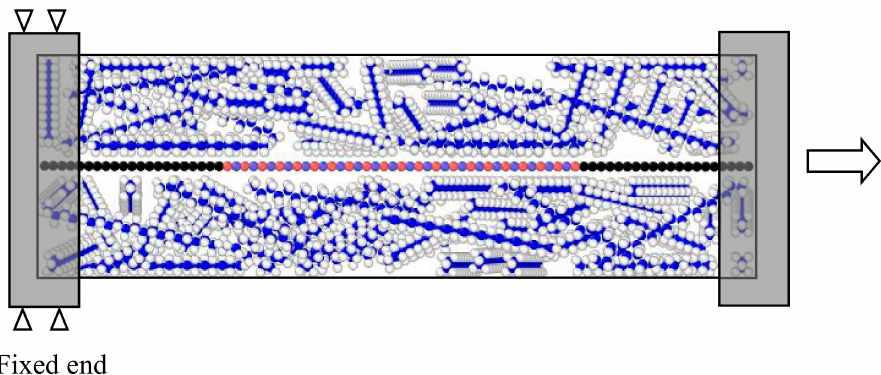
Figure 2. Description of tensile loading of the BN–C nanosheet reinforced PE nanocomposite in the study. In the PE matrix, carbon atoms are depicted by blue colored balls and hydrogen atoms are depicted by white colored balls. In the BN–C nanosheet, the carbon, boron, and nitrogen atoms are depicted by black, ochre, and purple colored balls, respectively. The figure is a representative image of the simulation box with enhanced distinction between the matrix and nanosheet regions for easier